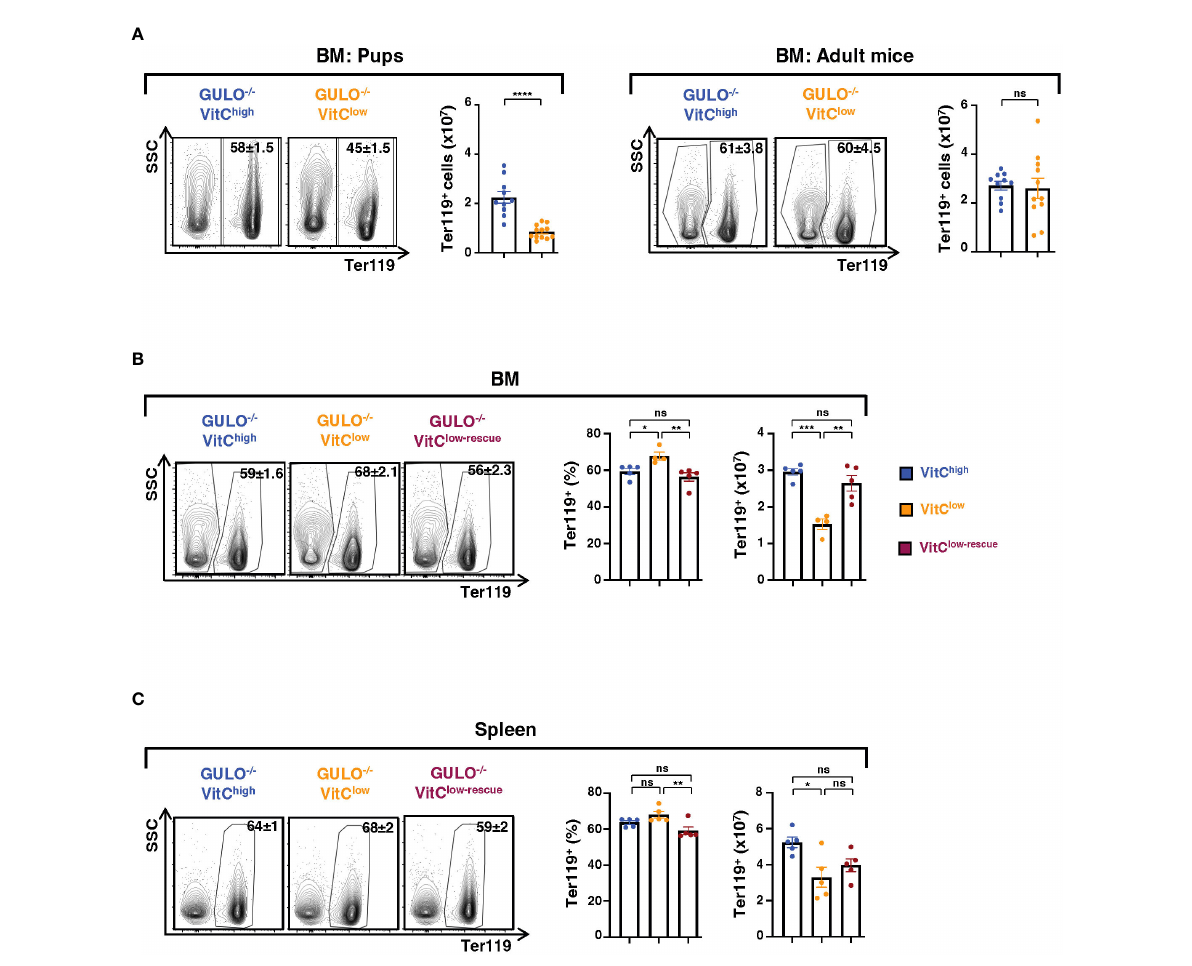
FIGURE 5 Ascorbate deprivation leads to decreased erythroid cells in GULO -/- pups. (A) Ter119 + erythroid BM cells were quanti fi ed in pups (left) and adult (right) GULO -/- mice supplemented with 1g/L of vitamin C (GULO -/- VitC high ) or 0.1g/L of vitamin C (GULO -/- VitC low ; n=10-12 mice per group). Representative contour plots are shown and quanti fi cation of Ter119 + cells are presented as means ± SEM. (B) Ter119 + BM cells were evaluated in 28 day old GULO -/- mice maintained under VitC-high, VitC-low, and rescue conditions. The percentages and absolute numbers of Ter119 + cells are shown (n=5 per group). (C) Splenic Ter119 + erythroid cells were evaluated as in panel (B) and means ± SEM are presented (n=5 mice per group). Statistical differences were analyzed using an unpaired two-tailed t-test in panel (A) ; and a one-way ANOVA (Tukey ’ s test) in panels (B, C) . *p < 0.05; **p < 0.01; ***p < 0.001; ****p < 0.0001; ns, not signi fi